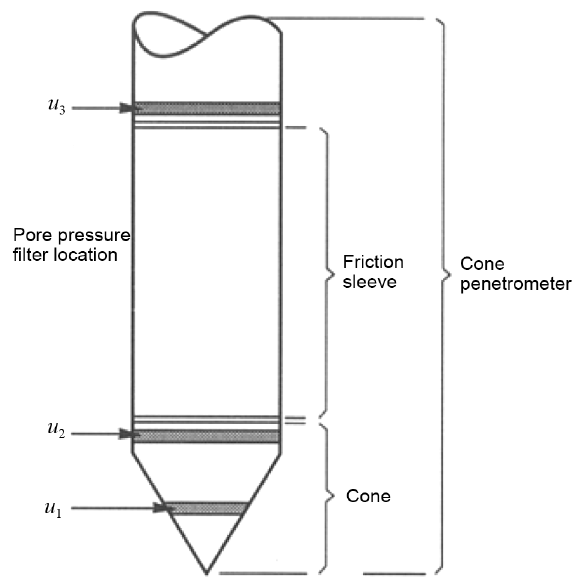
Fig. 1. 36 mm (top) diameter penetrometer and terminology for cone penetrometers (Lunne et al.